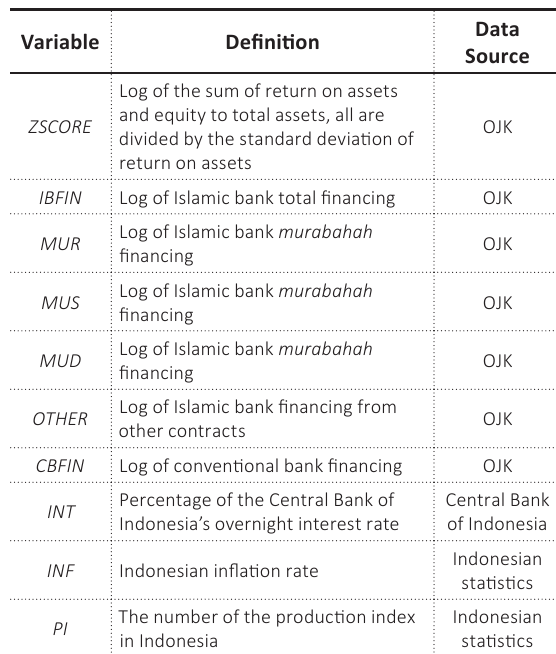
Table 1. Definition of